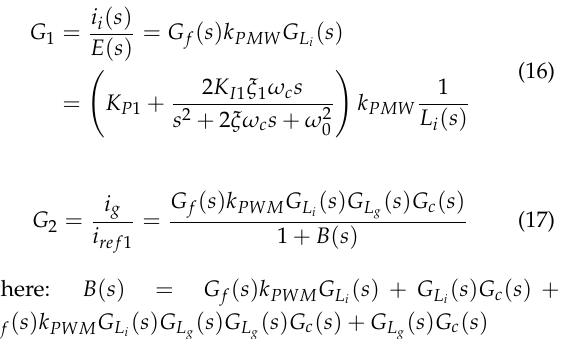
Fig. 6. Bode diagram of closed loop transfer